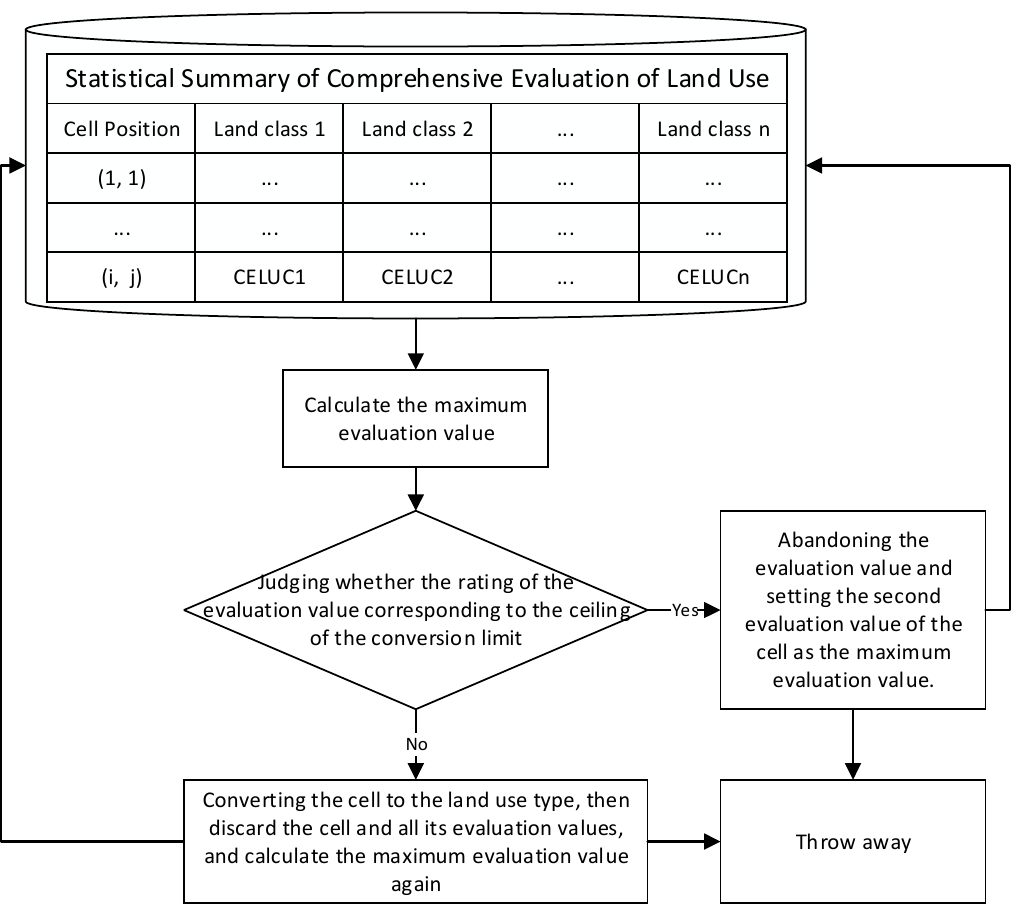
Figure 9. Cell’s land-use-type conversion flow.